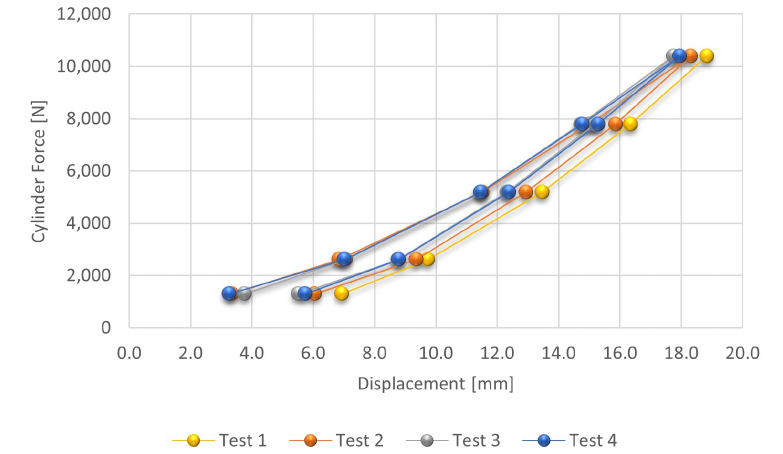
Figure 4. Displacement results as a function of the applied force during the loading and unloading of the mockup tower